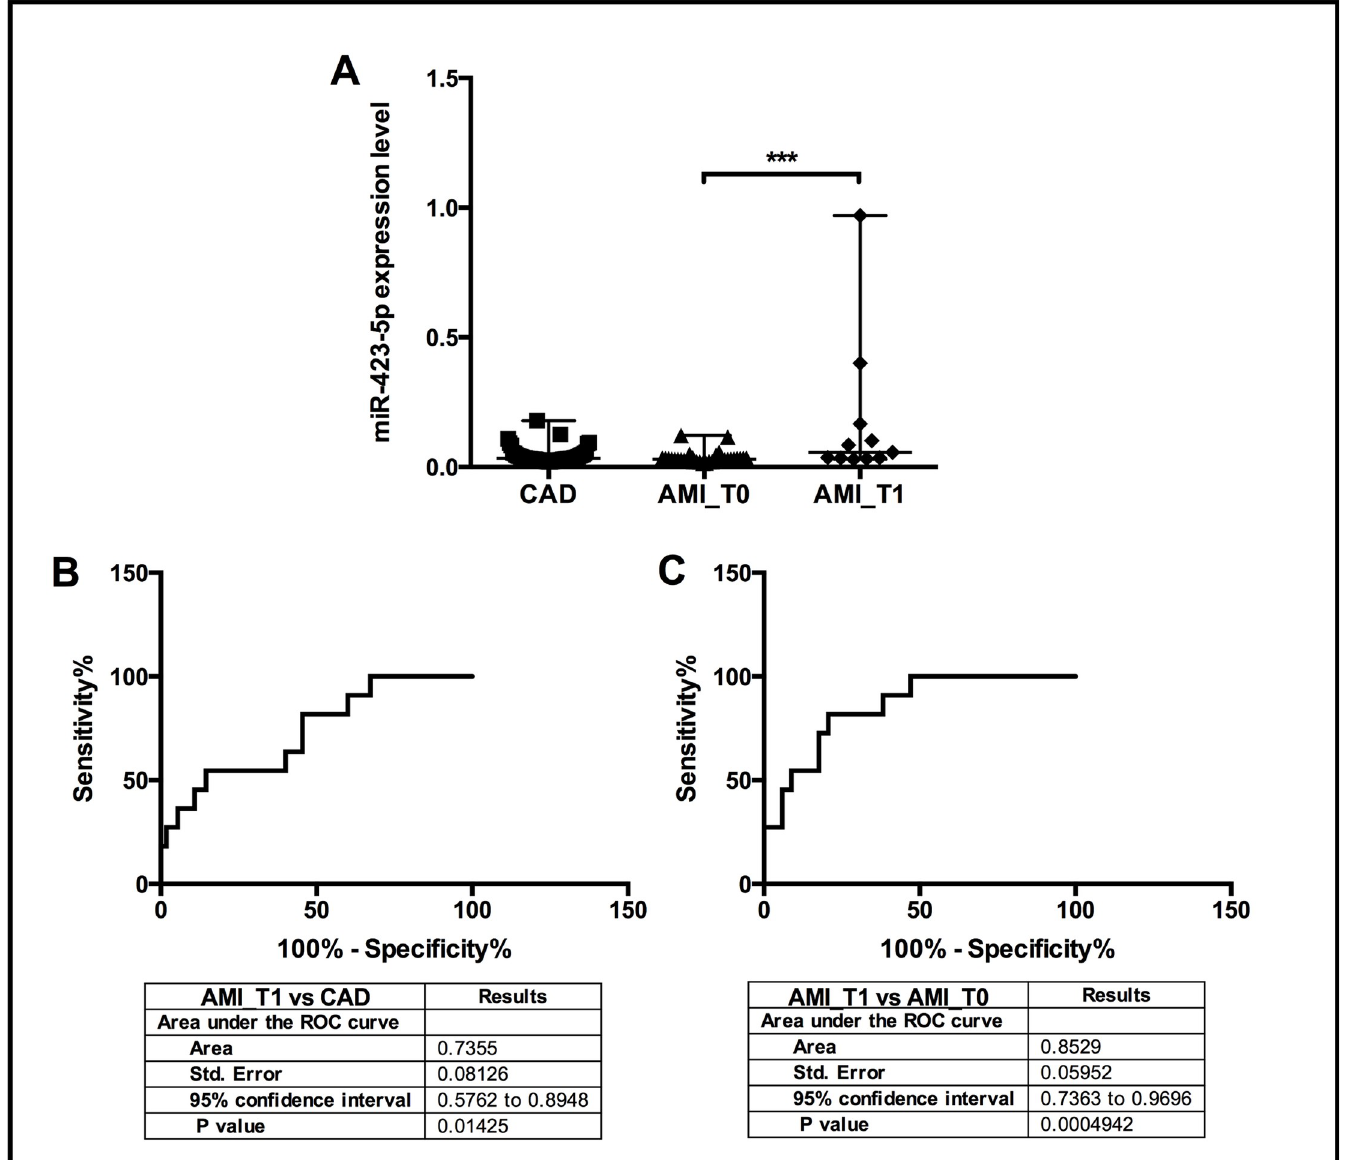
Fig 5. MiR-423-5p expression in PBMCs (n = 3). (A) MiR-425-5p expression in PBMCs of CAD, AMI_T0 and AMI_T1 patients. Kruskal-Wallis statistic 11.93, p � 0.005. Discriminatory power of miR-423-5p expression in PBMCs. (B) Receiver operator characteristic (ROC) curves for AMI_T1 vs CAD (set as control group). (C) Receiver operator characteristic (ROC) curves for AMI_T1 vs AMI_T0 (set as control group).